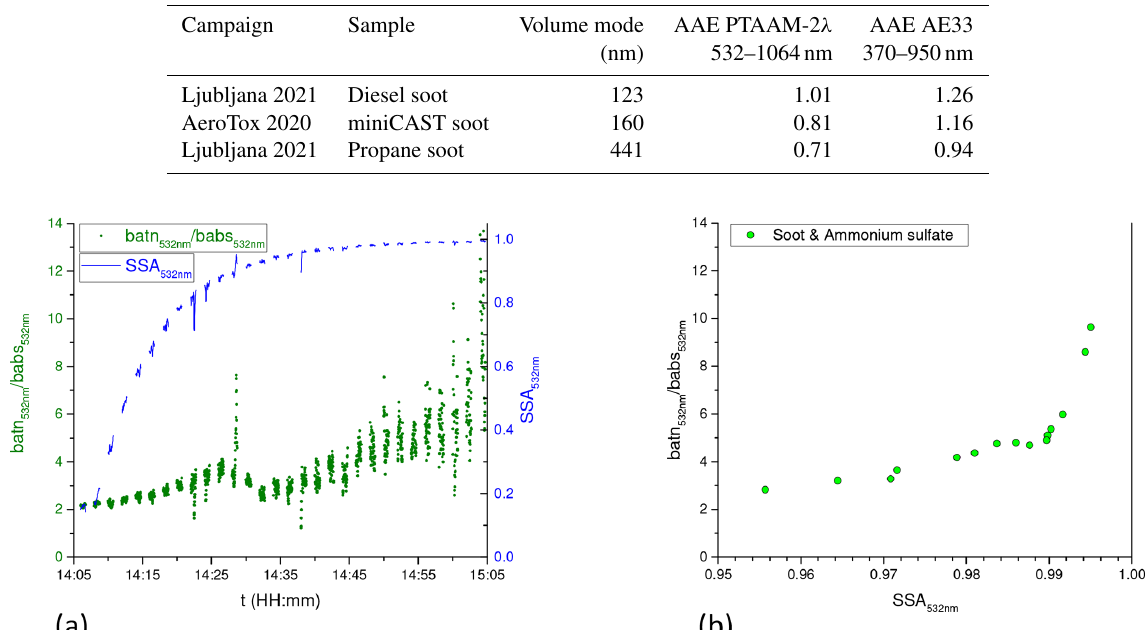
Figure 15. Measurement of externally mixed diesel soot and ammonium sulfate. The ratio between the AE33 attenuation coefficient and the PTAAM-2 λ absorption coefficient and single-scattering albedo as a function of time (a) . There was a filter change for the AE33 at 14:28LT. Attenuation-to-absorption ratio as a function of the single-scattering albedo (b)